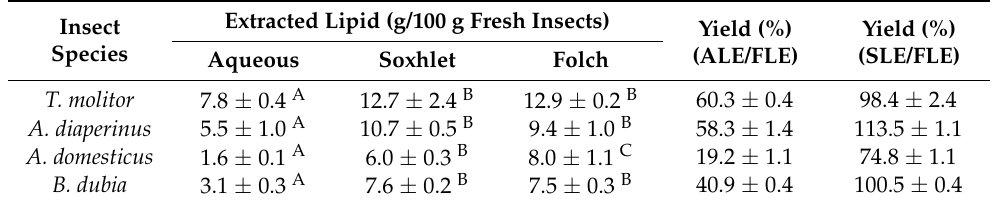
Table 3. Total lipid quantity extracted from four insect species after aqueous, Soxhlet, and Folch extraction expressed on the basis of live weight. Extraction yields of aqueous and Soxhlet extraction relative to Folch extraction (mean ± S.D., N = 3) [15]. Extracted Lipid (g/100 g Fresh Insect Species